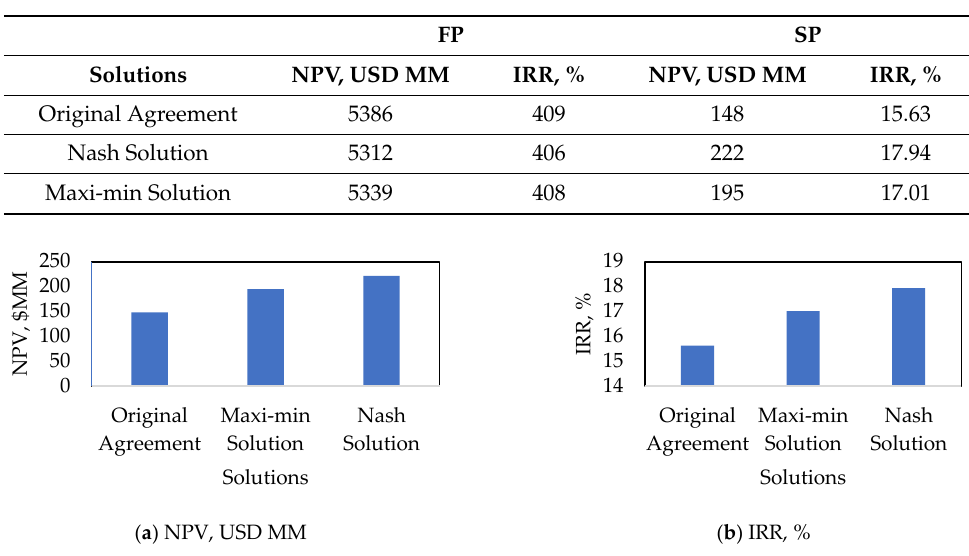
Table 12. The effect of the original agreement, Maxi-min, and Nash solutions on the economic indicators of FP and SP.